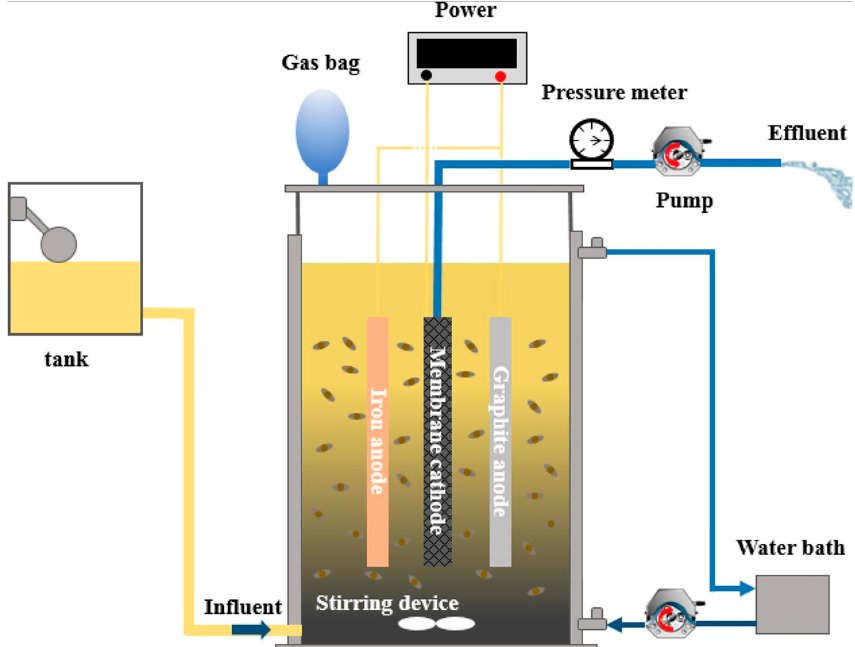
Figure 2. Schematic of AnEMBR. (Source: [118]; copyright permission received on 15 February 2023, from Elsevier).